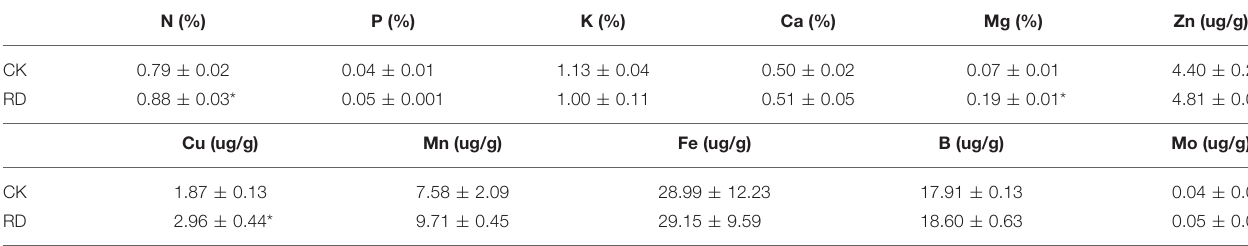
TABLE 3 | Mineral nutrients in mature CK and RD